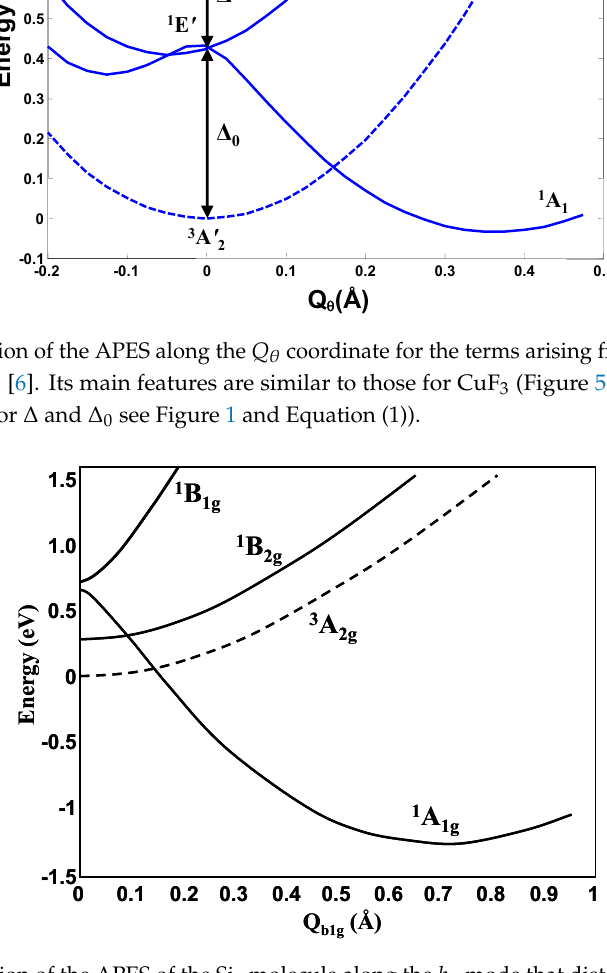
Figure 6. Cross-section of the APES of the Si 4 molecule along the b 1 -mode that distorts the system from square-planar to rhombic geometry due to the ( 1 A 1 + 1 B 1 ) ⊗ e PJT coupling between two excited states (cf. Figure 3).